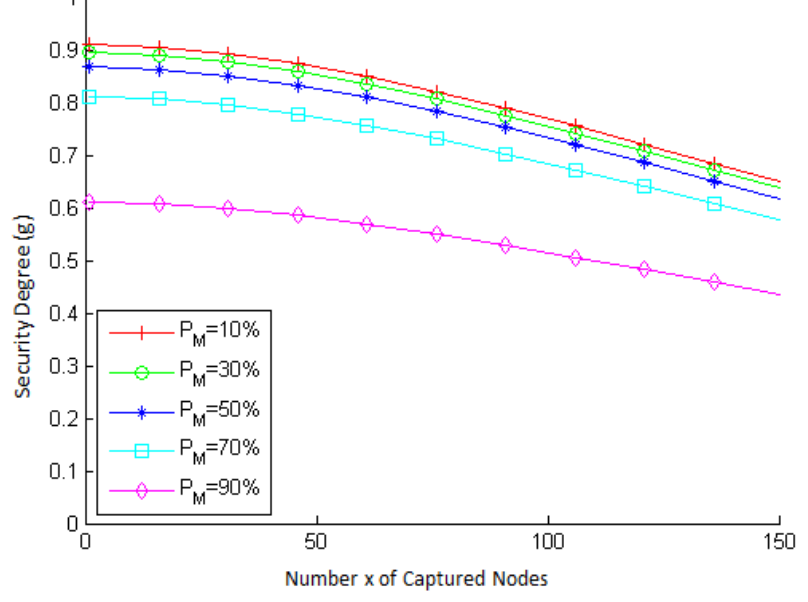
Figure 8. Security degree of a node for which a global alarm is not generated ( A − ) vs. the amount x of captured nodes, for different values of base rate ( P sensor